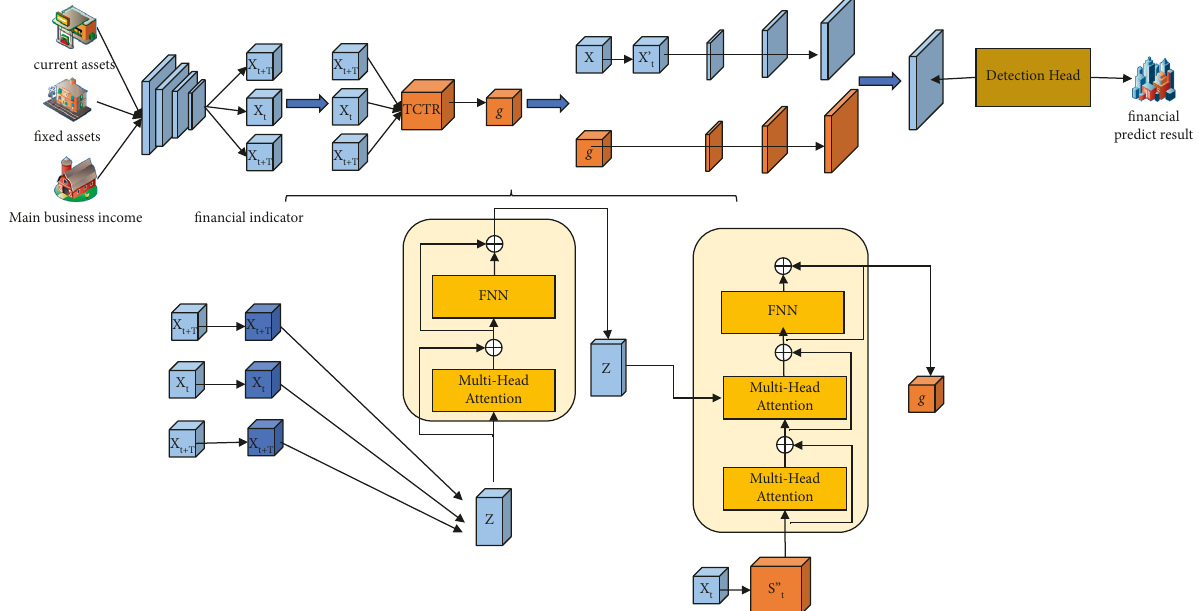
Figure 1: Financial early warning model based on data reasoning and